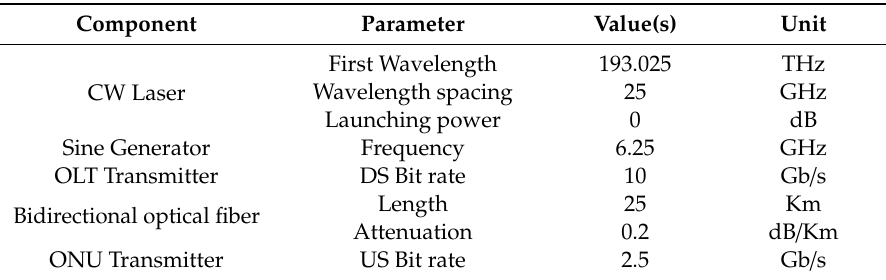
Table 1. The main parameters for the proposed DWDM-PON system components.